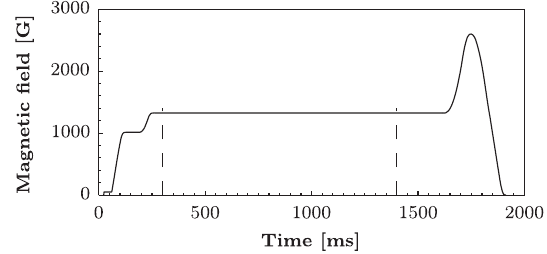
FIG. 2. Magnetic cycle of the PS as used for the measurements. The first plateau starting at 170 ms corresponds to injection kinetic energy at 1.4 GeVand the long plateau starting at 250 ms to 2 GeV. For each working point the evolution of the transverse profiles was recorded between 300 ms and 1400 ms as indicated by the dashed lines. The final acceleration is required to extract the beam towards the beam